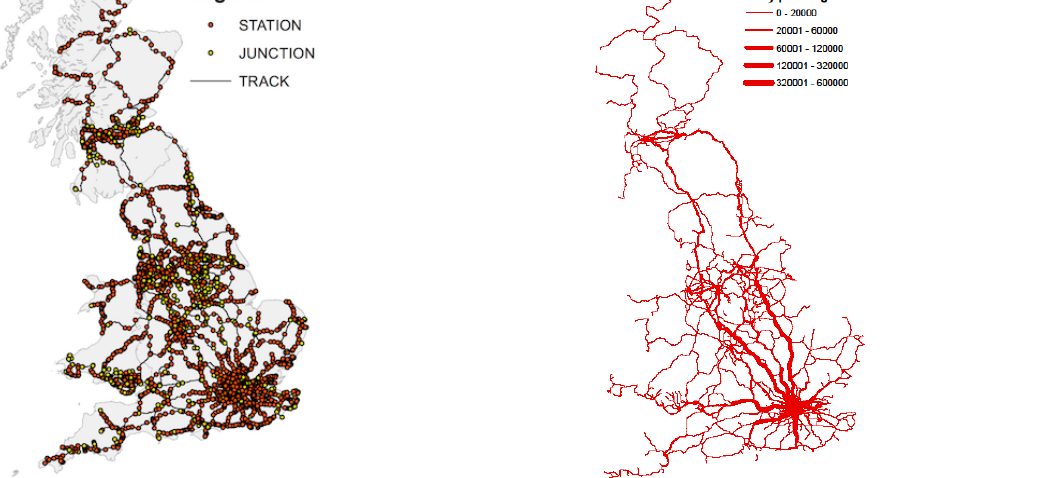
Figure 2. Topological railway network for Great Britain showing stations, junctions and tracks.